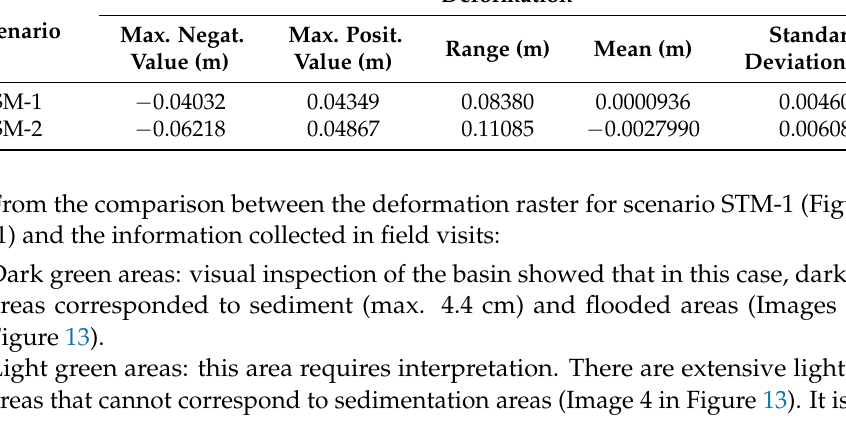
Table 4. Global deformation results of scenarios STM-1 and STM-2.